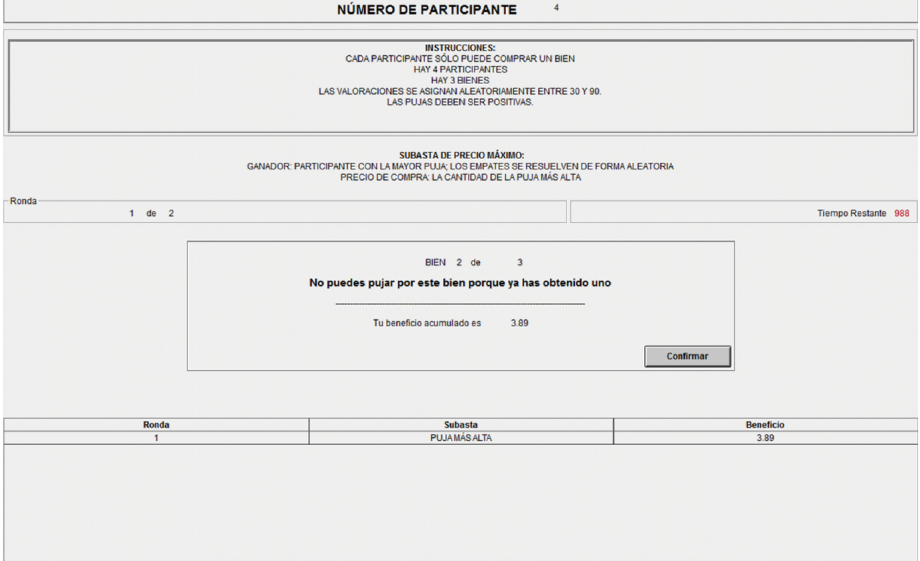
Figure A1.2. Not allowed to bid as a previous winner